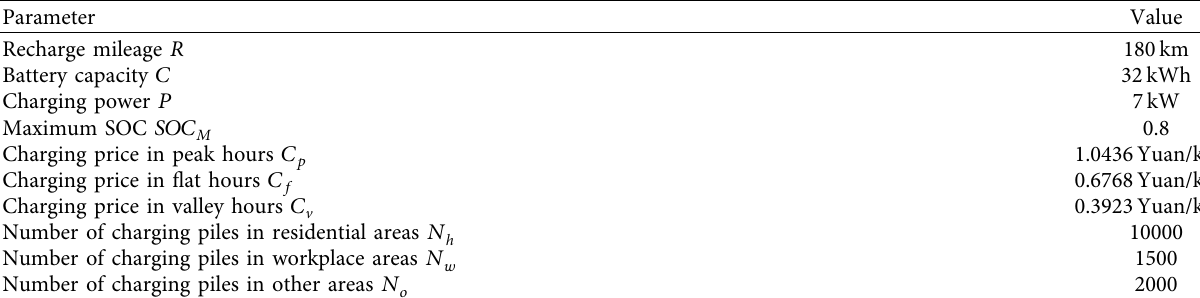
Table 2: Basic parameters.